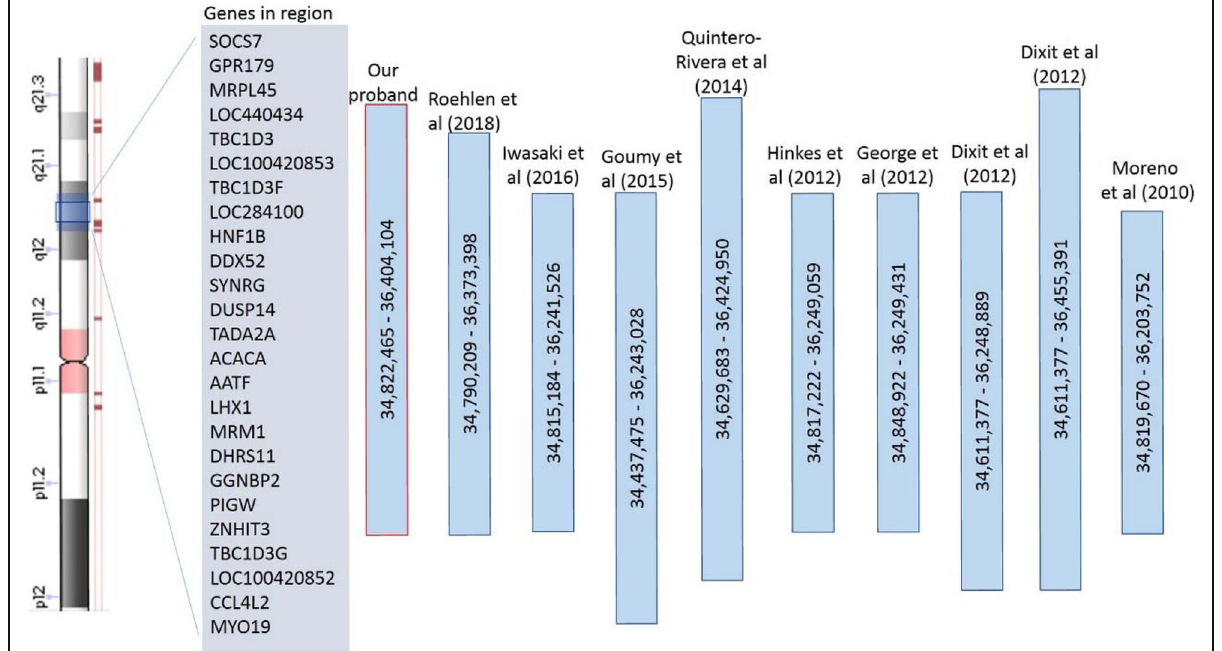
Fig. 2 Comparison of deleted regions of Chr17q12. All genomic coordinates were converted to GRCh37/hg19 for